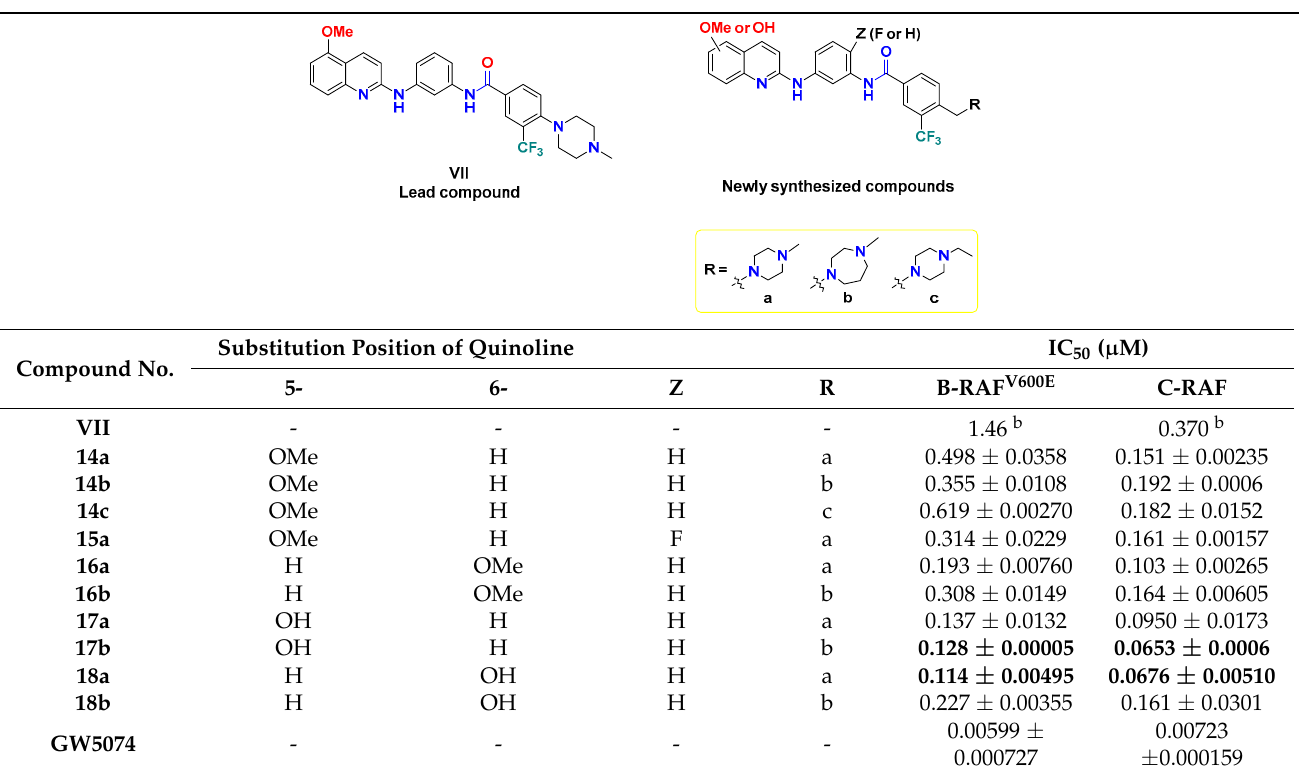
Table 1. In vitro kinase inhibitory activity (IC 50 , µ M) of the lead compound VII and target compounds against B-RAF V600E and C-RAF a,b,c .